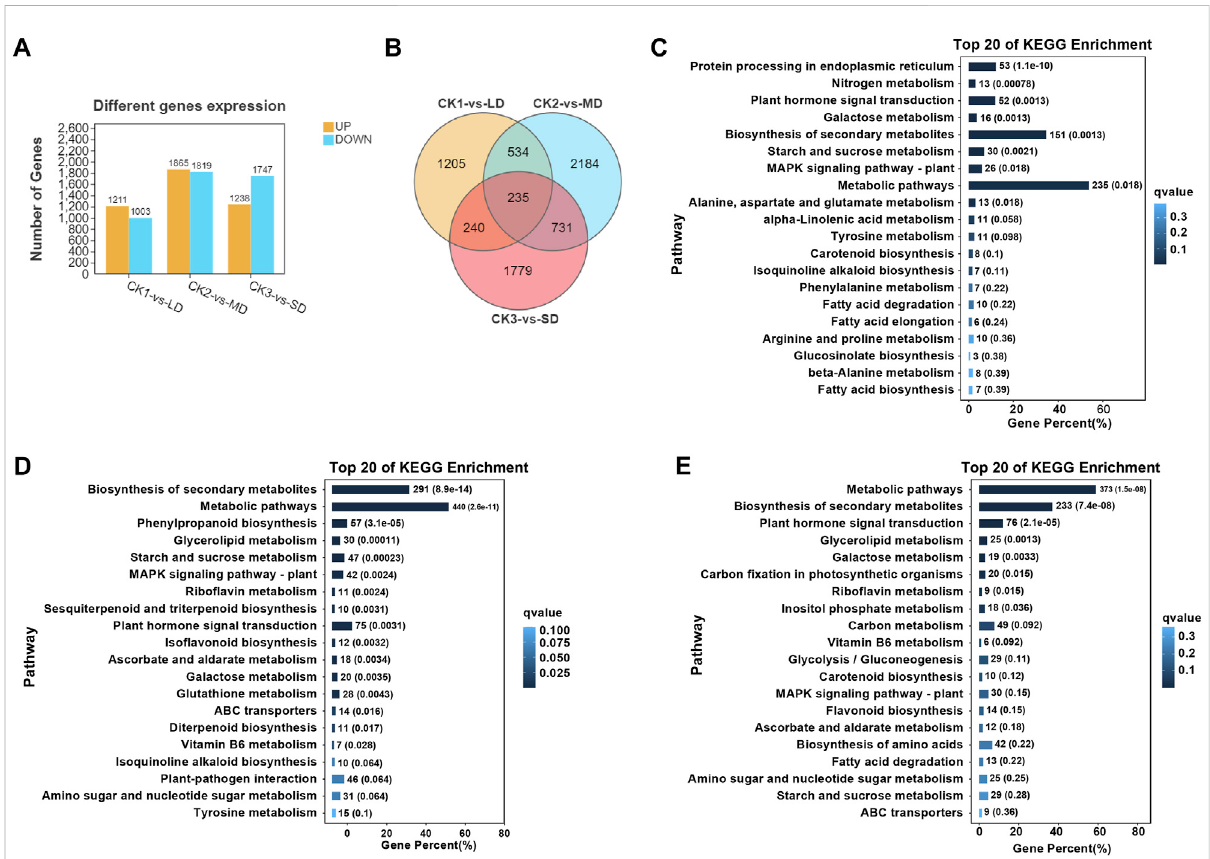
FIGURE 2 Transcriptional analysis of soybean under various drought stresses. (A) The numbers of DEGs. (B) Venn diagrams show the overlapping DEGs betweenthethreedroughtstress. (C) Thetop20enrichedofKEGGpathwaysinsoybeanunderLD/CK1. (D)